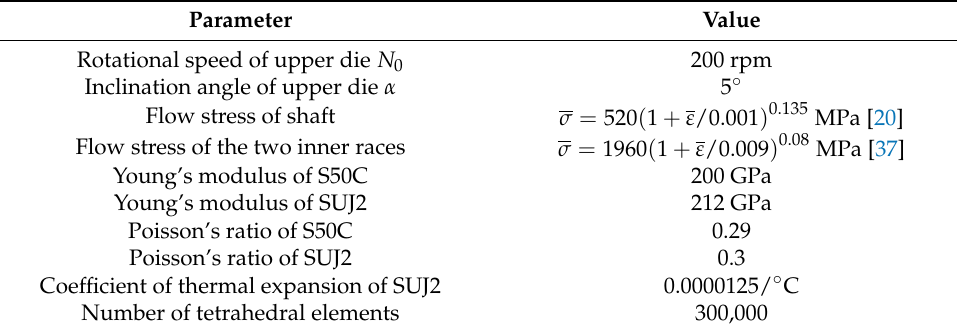
Table 1. Material properties and process conditions.